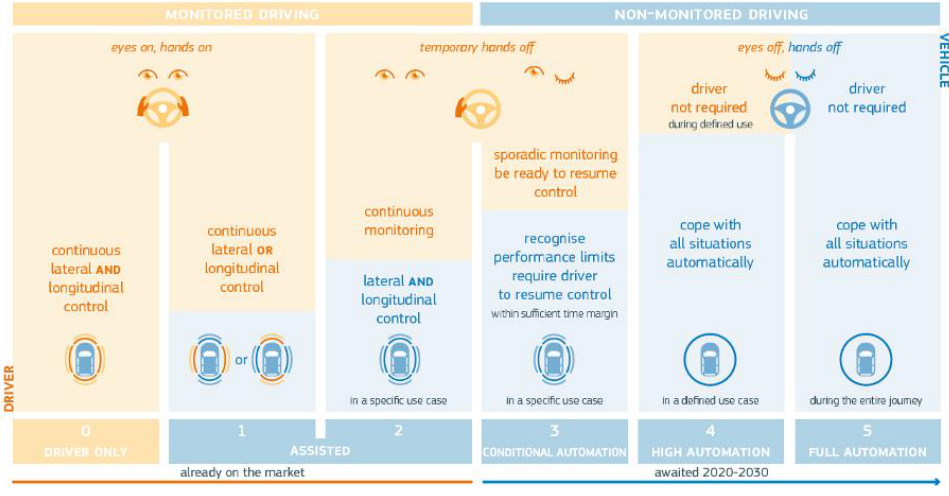
Figure 2. SAE J3016 automation levels [3].